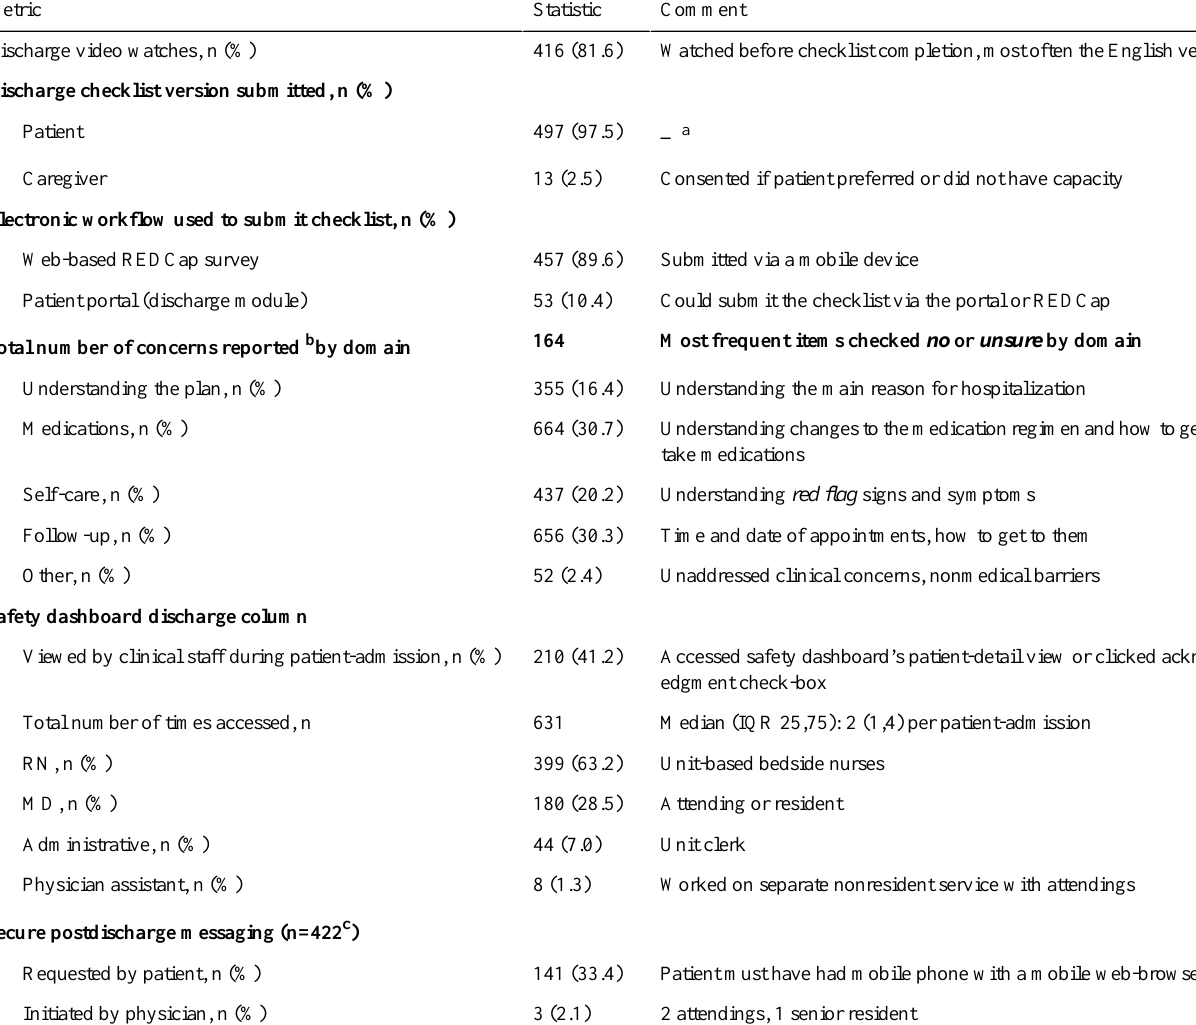
Table 4. Usage of patient-centered discharge toolkit component during 510 patient-admissions (480 unique